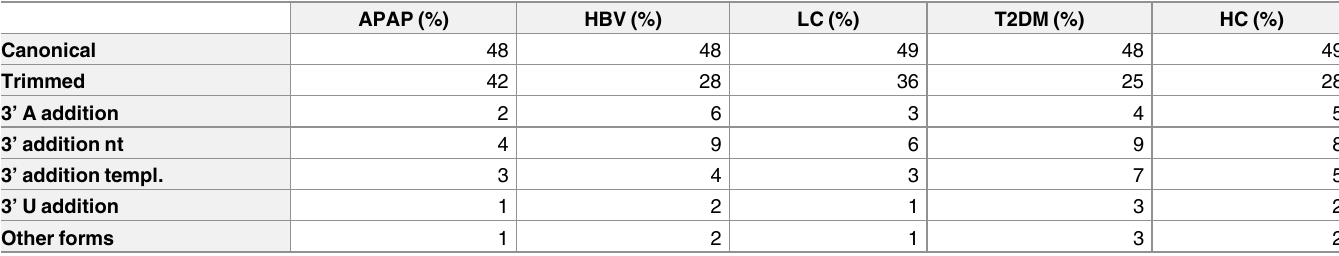
Table 2. IsomiR proportions among the liver impairments and T2DM.